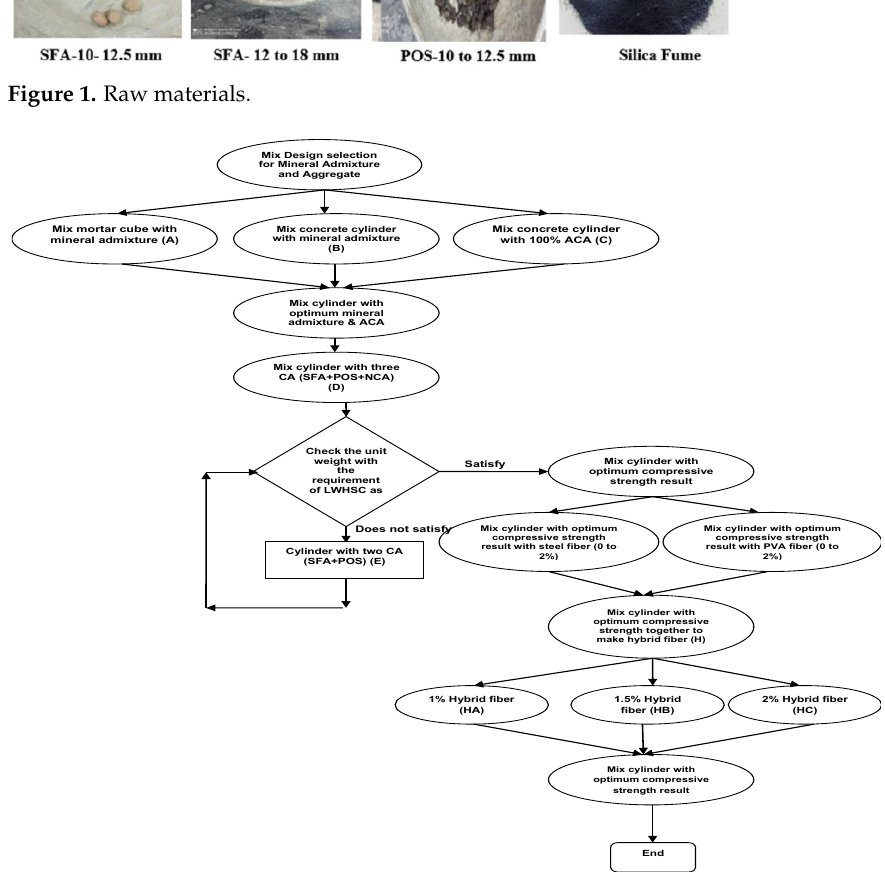
Figure 2. Flow chart of primary mix design.